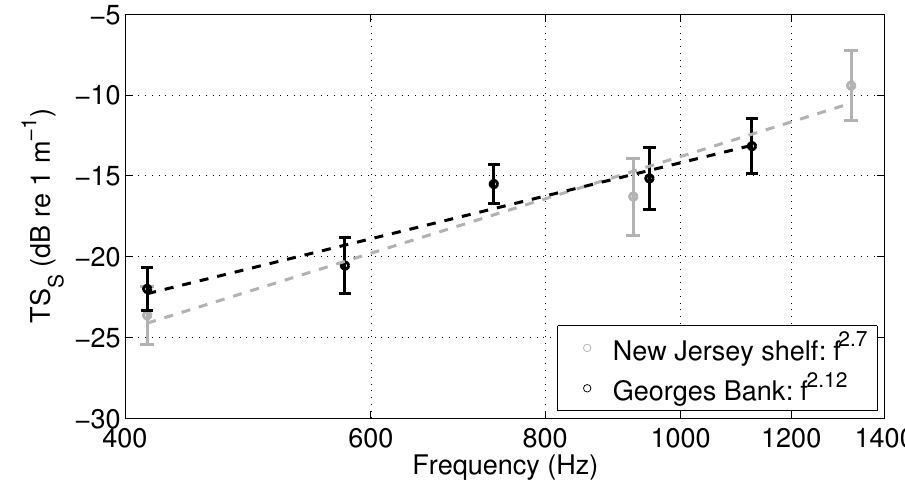
Figure 3. Frequency dependence of the experimentally estimated magnitude squared | 2 (Equation (12)), which is proportional to the of seafloor scattering amplitude, | A S scattering cross-section, in terms of a volume adjusted target strength defined as TS (cid:17) (cid:16) | A S | 2 10 log , for the New Jersey continental shelf (gray circles) and Georges Bank 10 V ref /r 4 ref environment (black circles) along with the respective standard deviations (solid tick marks). The overall frequency dependence of the magnitude squared of seafloor scattering amplitude per coherence volume for both environments is approximately f 2 . 4 . In water, V and r = 1 m. ref